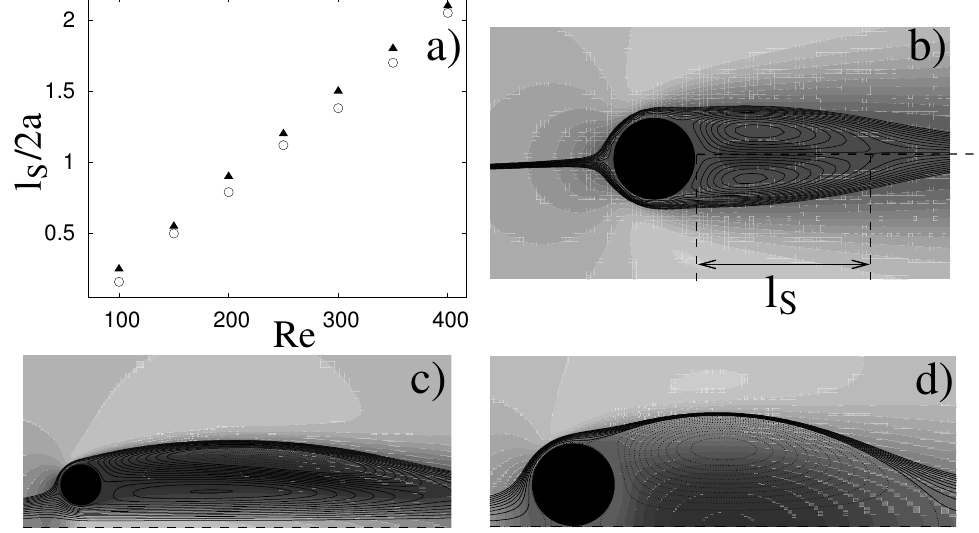
Figure 9. ( a ) Length of the separation bubble l S normalized by the core diameter versus Reynolds number: ◦ torus at Γ = 0.1, filled (cid:52) circular cylinder (from [10]). Instantaneous snapshots of streamwise velocity (gray scales) and Stokes streamfunction ( for positive for negative values); ( b ) Γ = 0.1, Re = 400; ( c ) Γ = 1, Re = 200; ( d ) Γ = 2, Re =